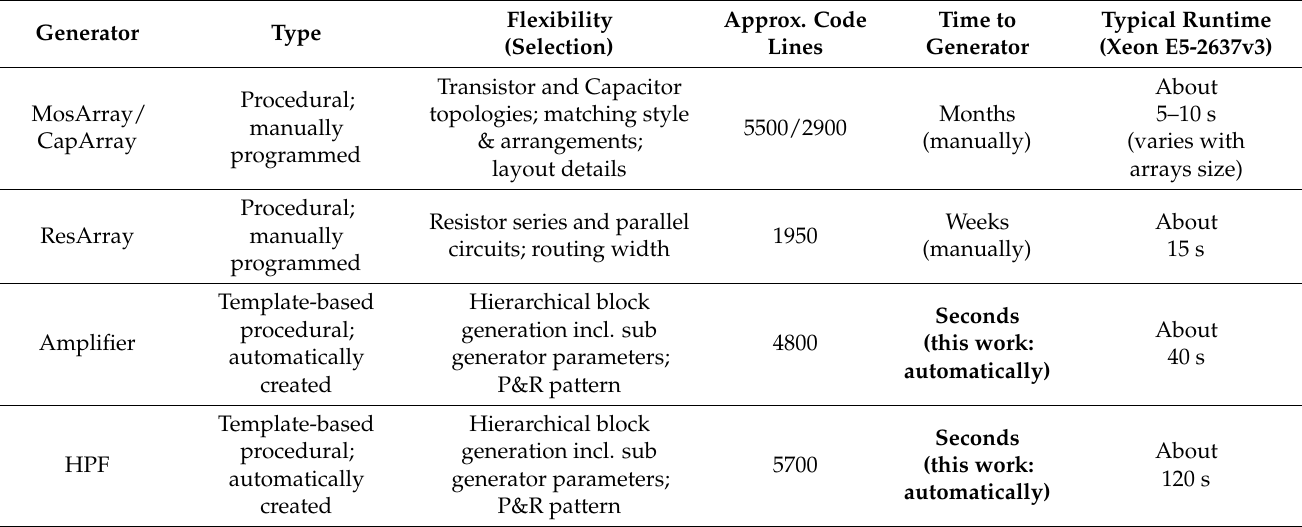
Table 3. Quantitative and qualitative comparison of the generators